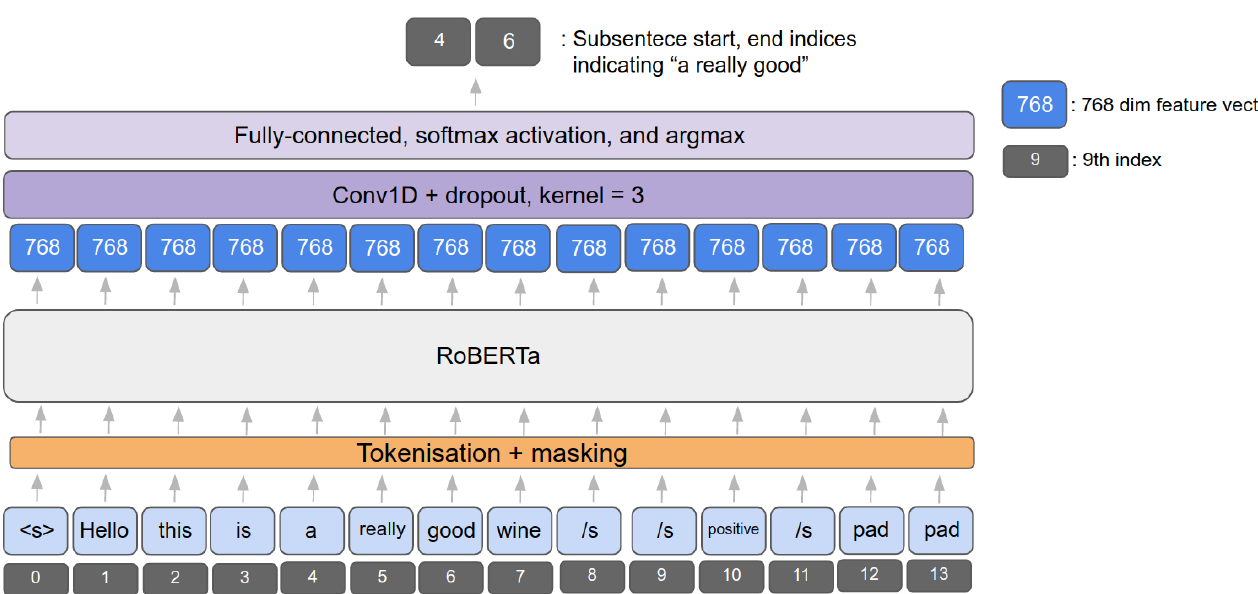
Figure 3. This diagram exemplifies how input sentence is processed using Robustly Optimized BERT Pretraining Approach (RoBERTa) model. Gray indicates a token index and blue is embedded output feature